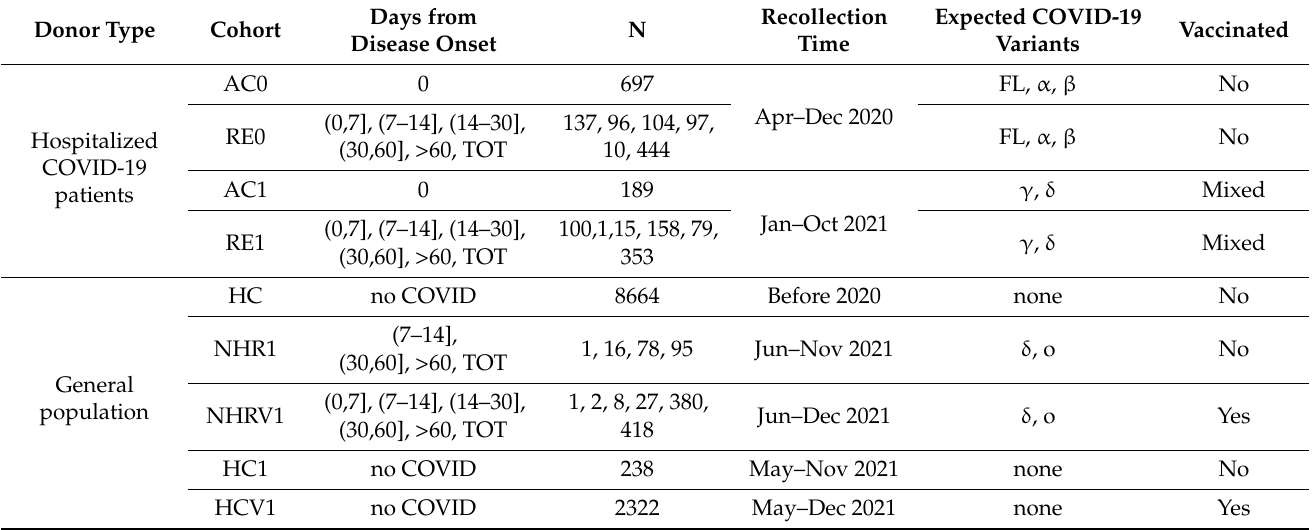
Table 1. COVID-19 and vaccination status for the cohorts under